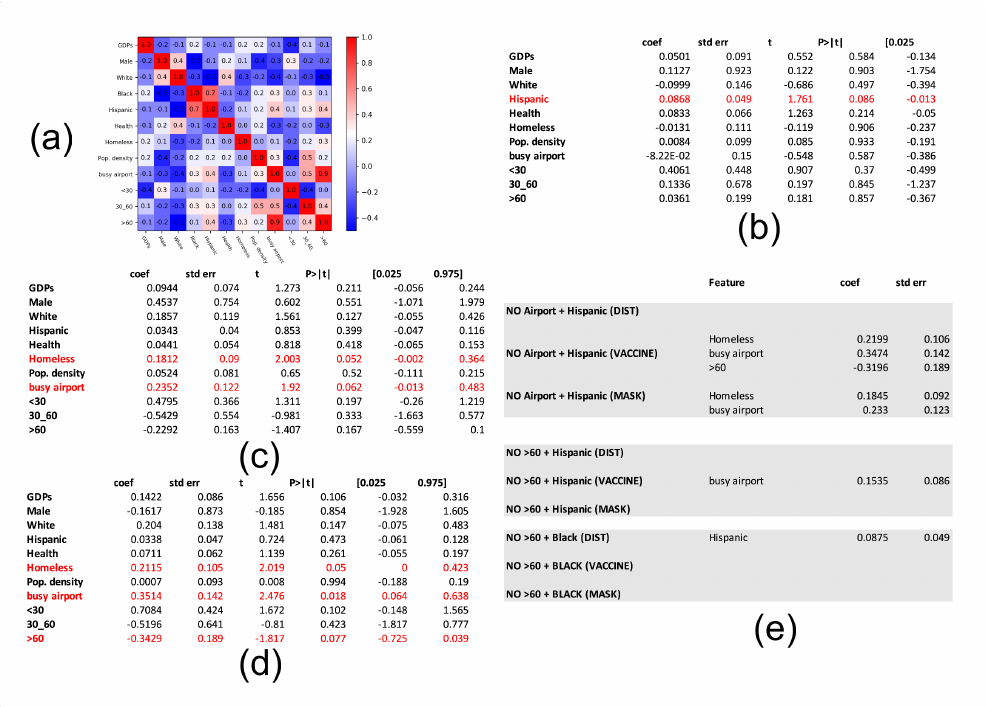
Figure 9. Regression analysis. ( a ) pairwise feature correlation; ( b ) complete regression table for feature set without airport and black features; significant features for regression of feature set without ( c ) airport and Hispanic) ( d ) age > 60 and hispanic, and ( e ) age > 60,